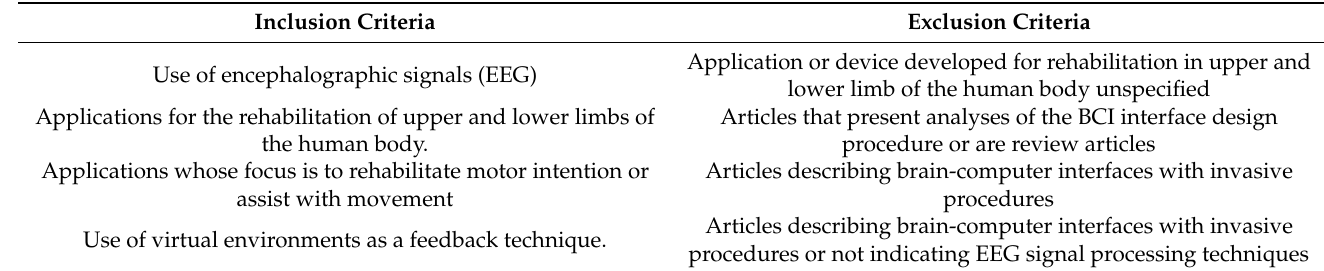
Table 1. Inclusion and exclusion criteria.